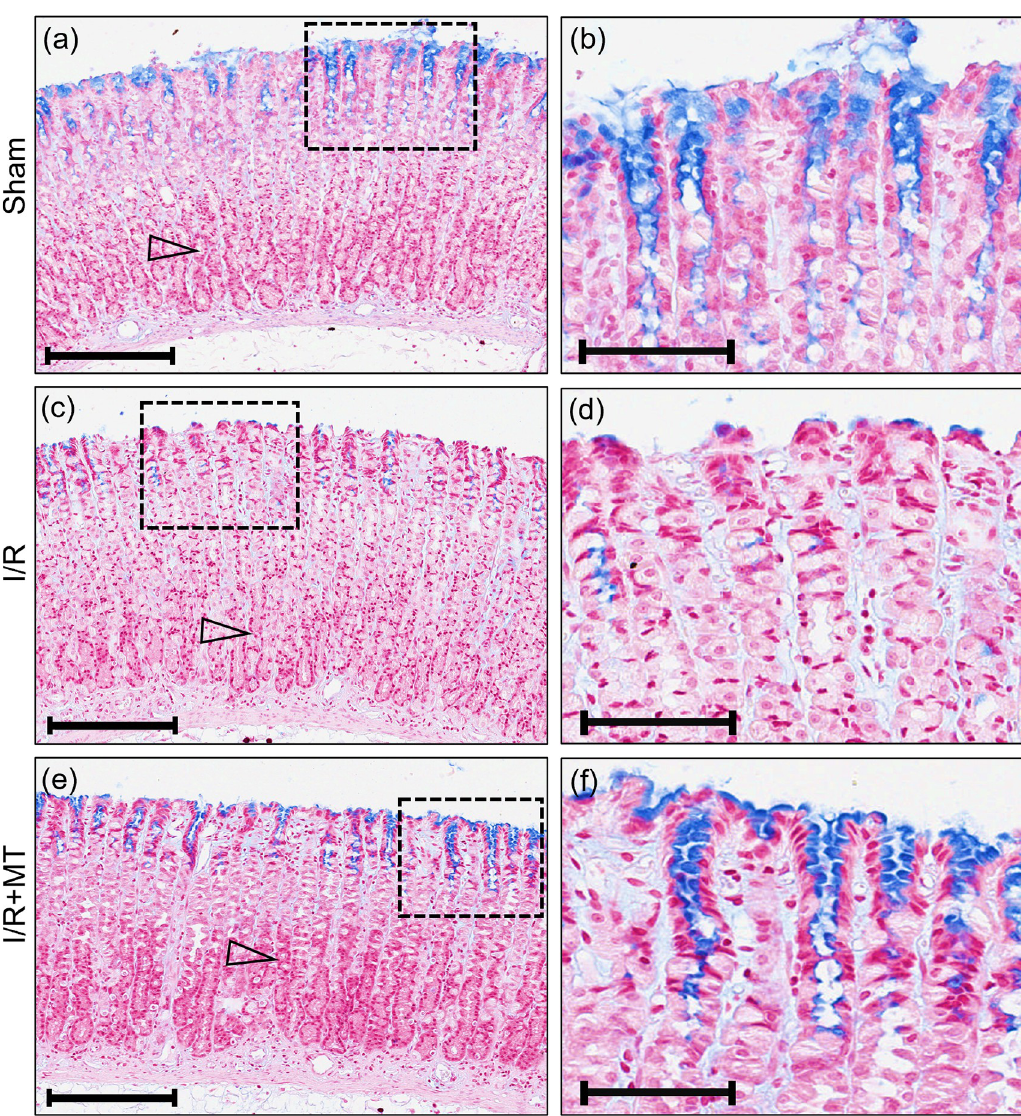
Fig 3. Effect of MT on alterations in mucinogen secretion in experimental groups. Representative photomicrographs of longitudinal sections (a) to (f) of rat gastric mucosa: Sham (a) and (b), I/R (c) and (d) and I/R+MT (e) and (f) groups. Identifier: (hollow arrowhead) PAS-positive cells. Scale bar: 200 μ m (a), (c) and (e). Magnification: Scale bar: 100 μ m (b), (d) and (f). Framed regions were enlarged to show the increase in mucin production in the superficial epithelium after MT treatment in the I/R